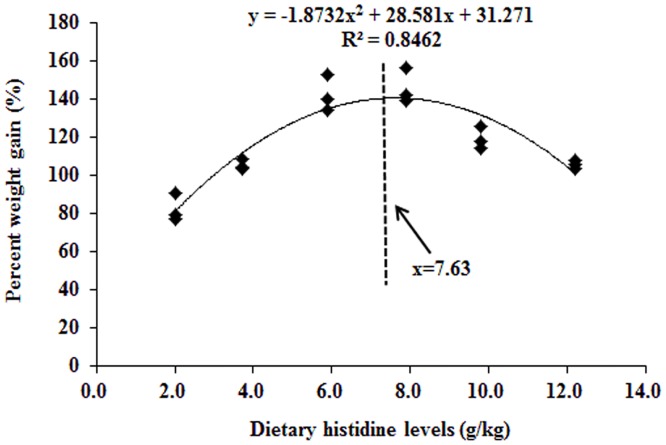
Quadratic regression of the percentage of weight gain of grass carps as a function of histidine dose.